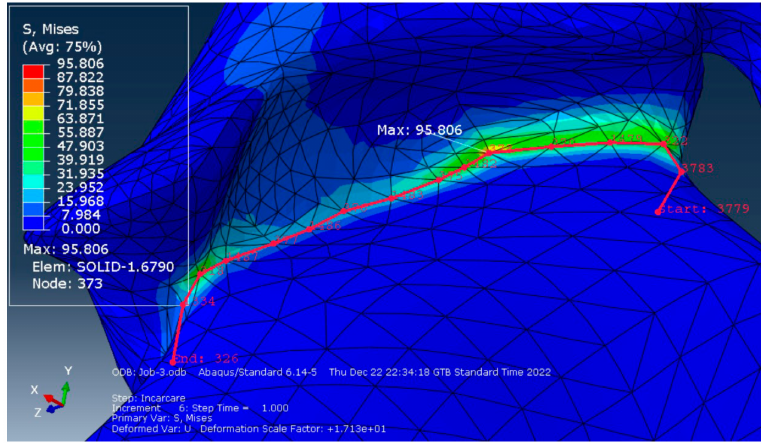
Figure 6. The path of nodes surrounding the point of maximum stress. After selecting the path of interest, a graph illustrating the stress variation in each of the selected nodes was plotted (Figure 7).